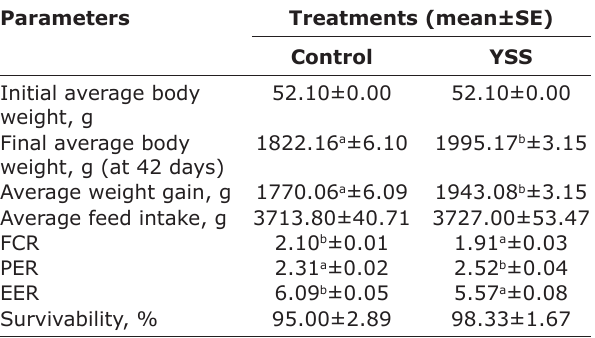
Table-2: The production parameters of broiler chicks.